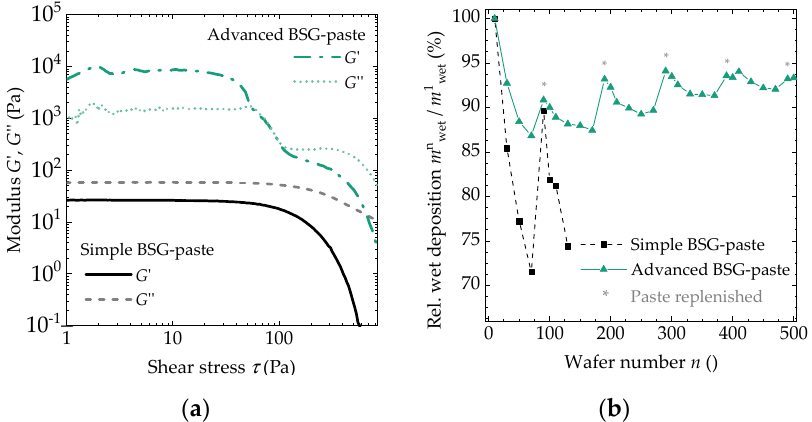
Figure 1. Rheological analysis and printing performance of different pastes. ( a ) Amplitude sweep of shear stress τ , showing the change of elastic and viscous moduli G ′ and G ″ , respectively; ( b ) printing test of different pastes. The relative amount of paste transferred m wet is measured in subsequent prints. Additional paste is added after 100 prints to maintain a sufficient paste reservoir (marked by a star “*”).